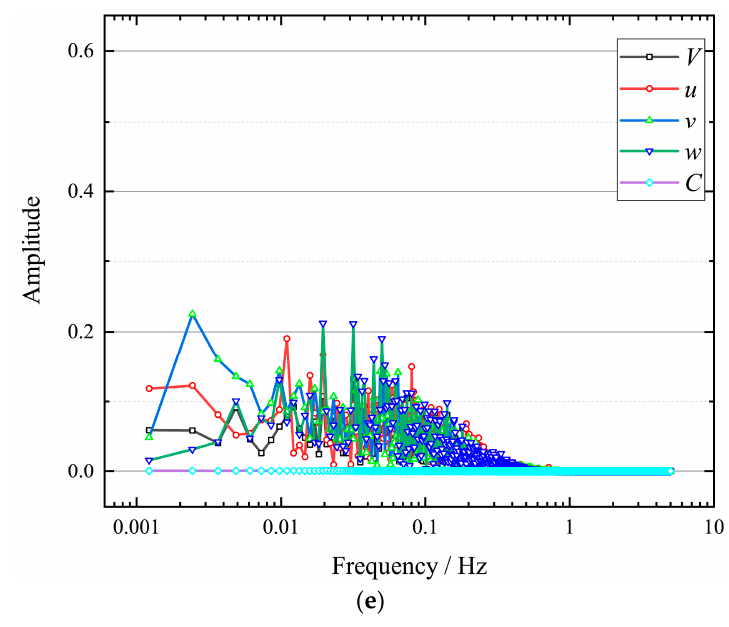
Figure 20. Comparisons of velocity and concentration amplitude spectra at five monitoring points: ( a ) Point 1; ( b ) Point2; ( c ) Point 3; ( d ) Point 4; ( e ) Point 5.